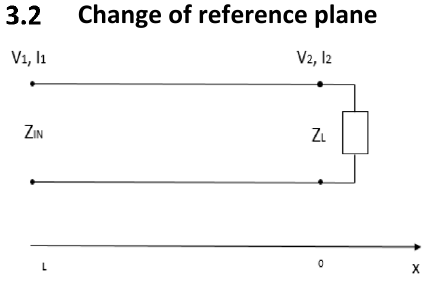
Figure 5. Change of reference plane in a transmission line.